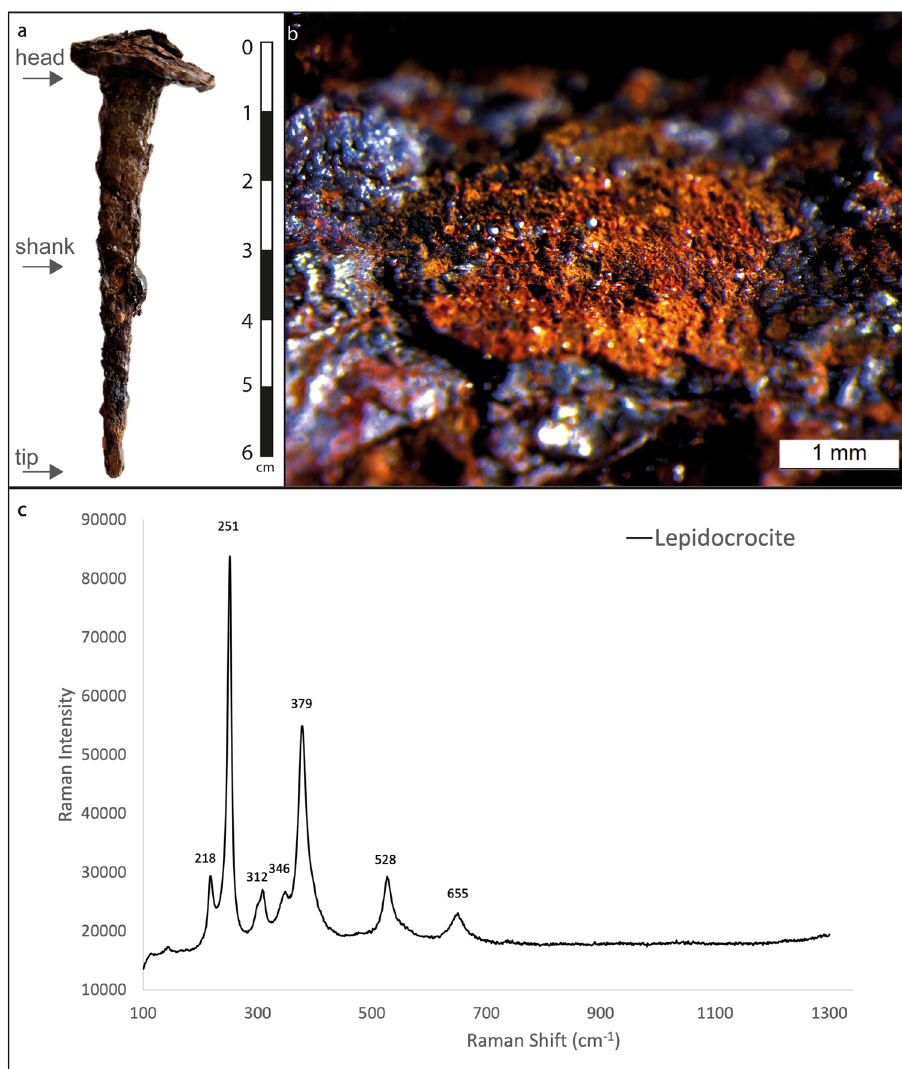
Figure 1. Mineralogical composition of nail patina. ( a ) Macroscopic view of the nail MF.03.53 ( b ) Optical microphotograph of reddish-brown patina and ( c ) Raman spectra of